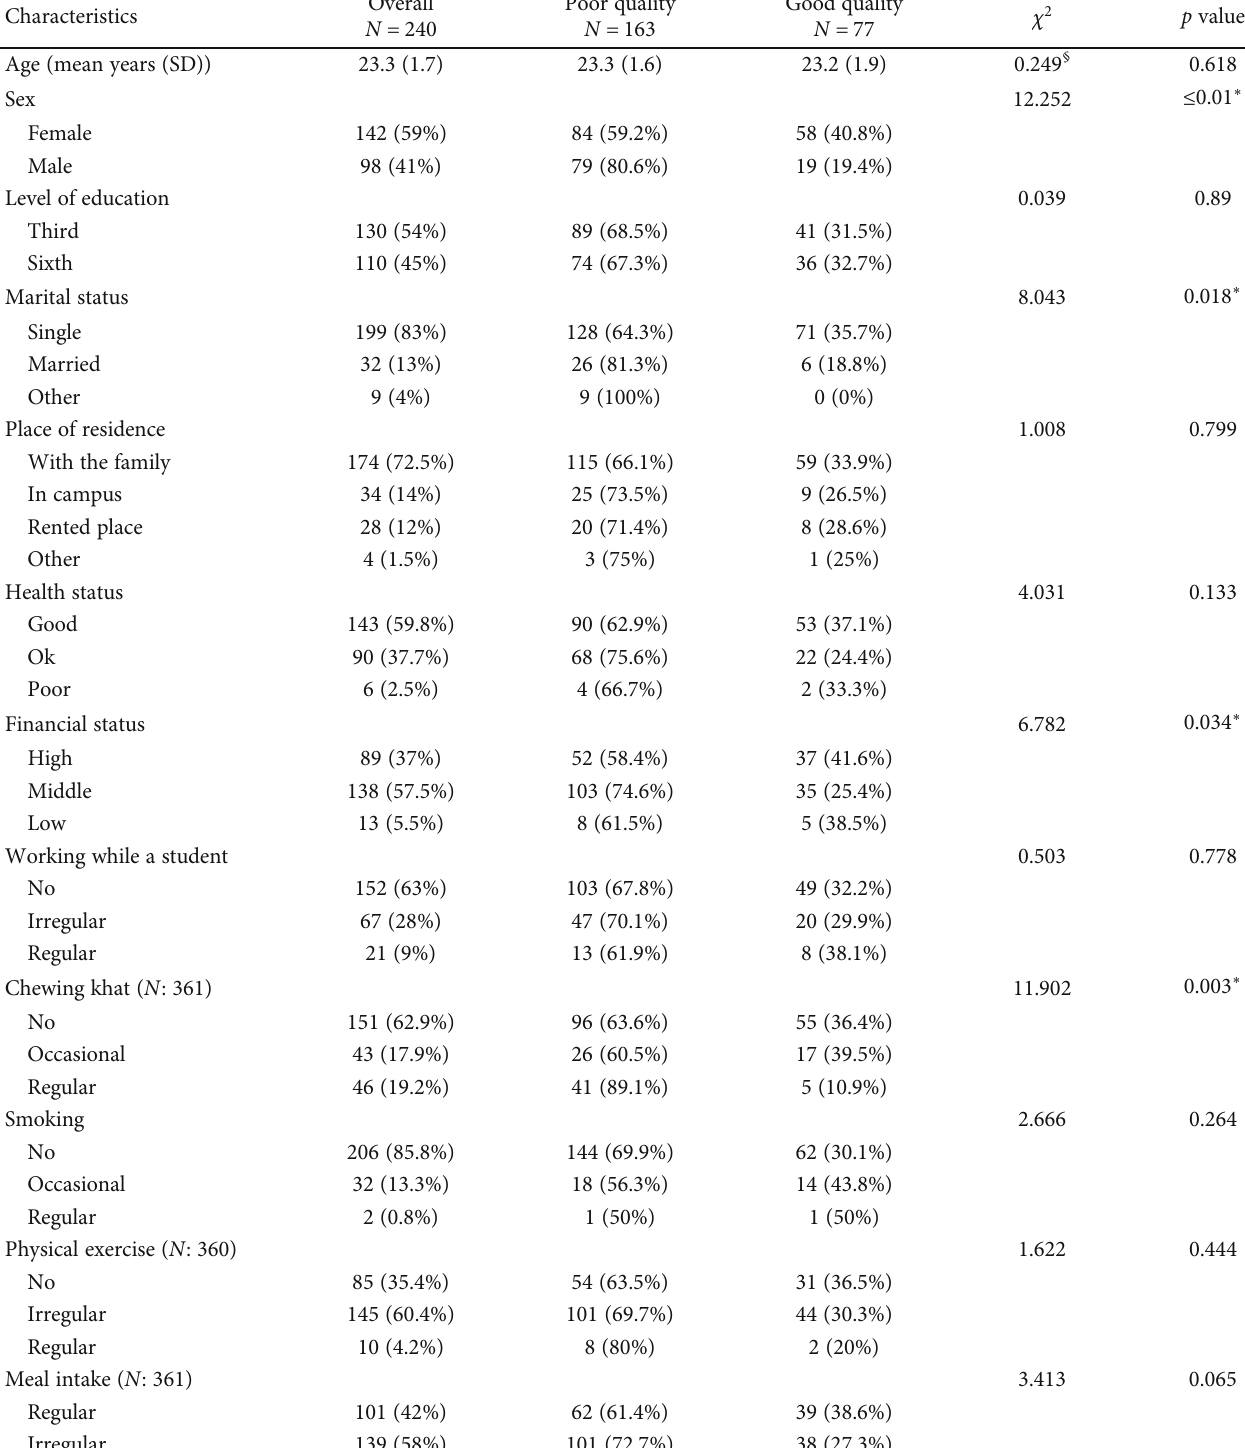
Table 1: Personal and life-style characteristics of the participants overall and per sleep quality group.